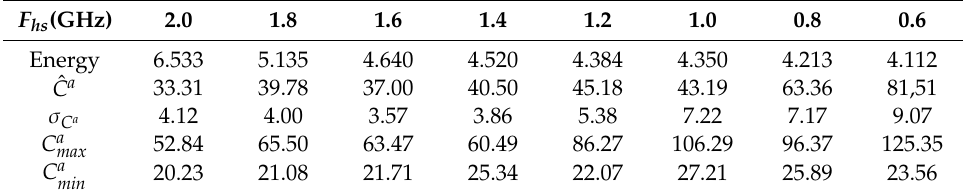
Table 8. Interactive governor with configuration 2 and di ff erent F hs values.